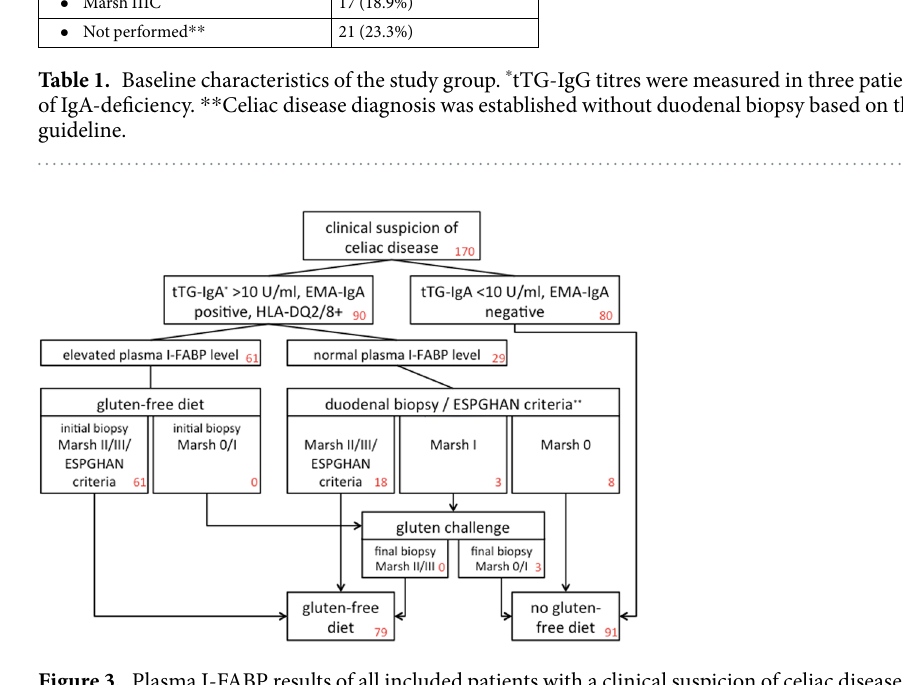
Figure 3. Plasma I-FABP results of all included patients with a clinical suspicion of celiac